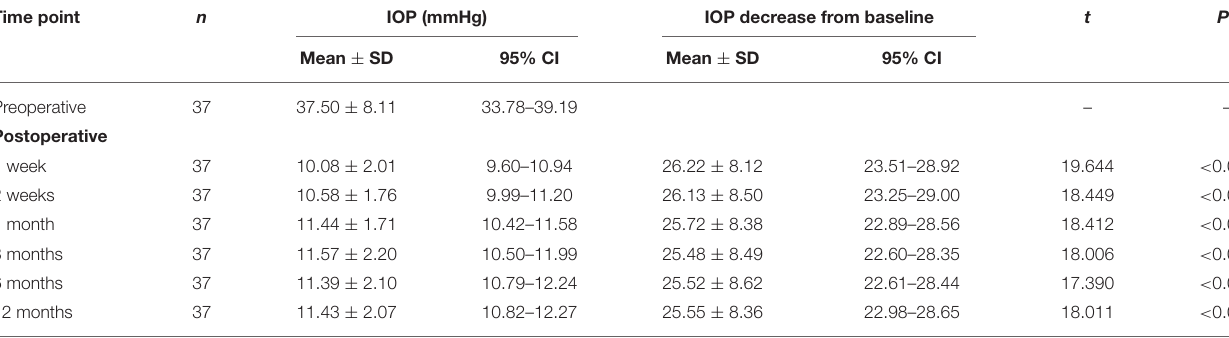
TABLE 3 | Changes in IOP before and after surgery.